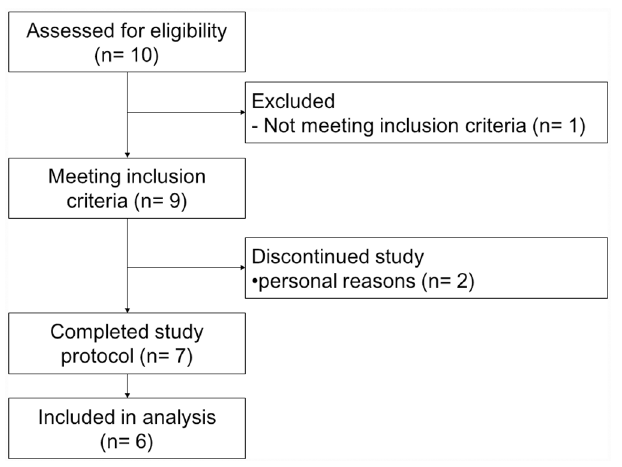
Fig 1. Flowchart of the